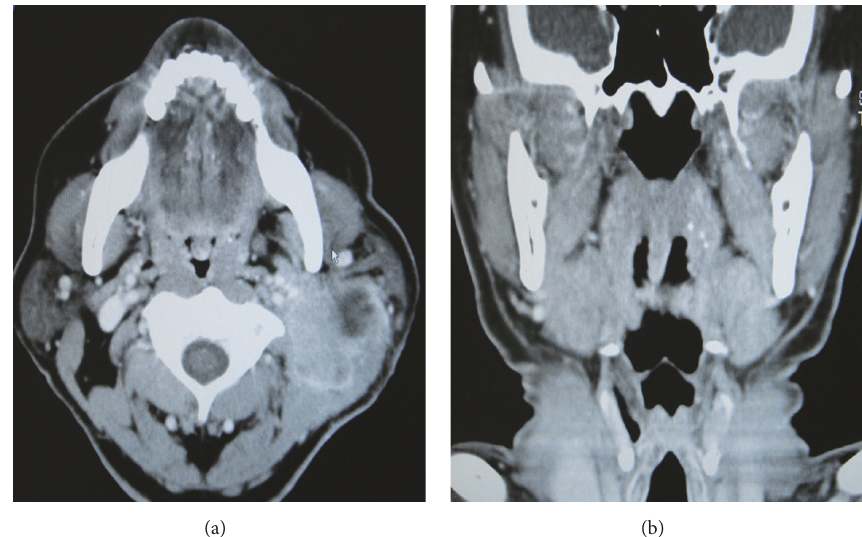
Figure 2: CT scan with contrast enhancement ((a) axial view; (b) coronal view). A CT scan demonstrated a cystic mass on the left side of the neck; however, tonsillar tumors were not